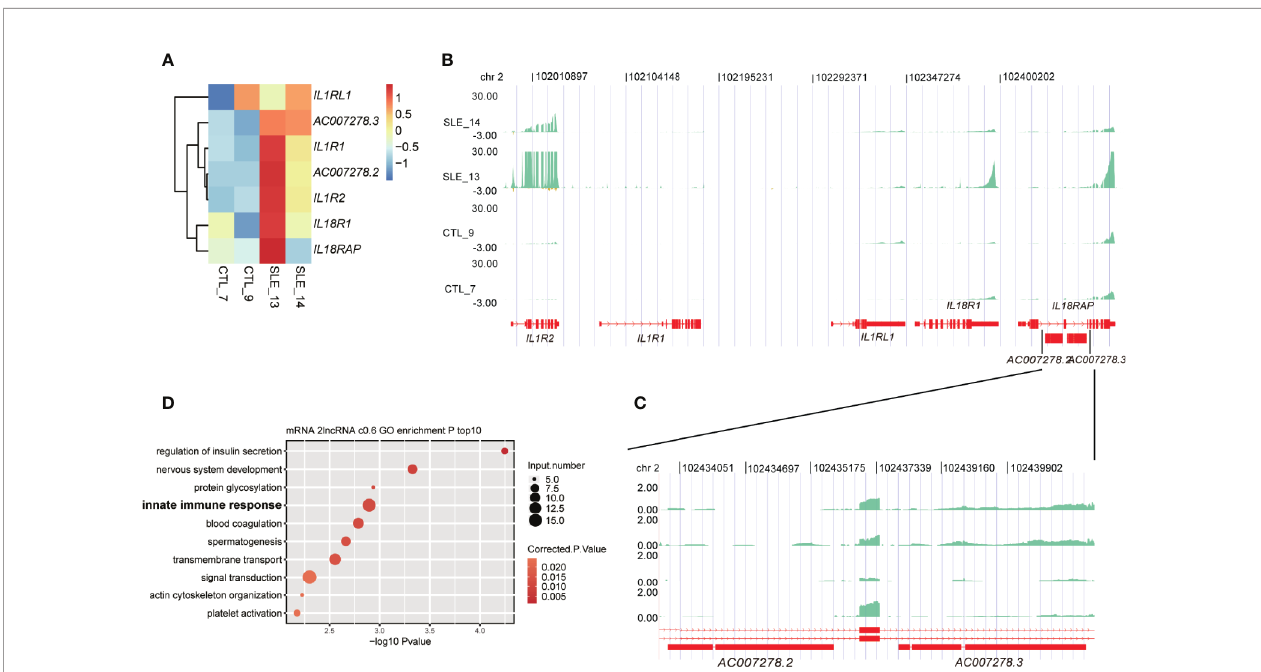
FIGURE 4 | One lncRNA cluster potentially regulated innate immune response-related gene expression. (A) Heat map shows the elevated expression levels of seven genes in the systemic lupus erythematosus samples in this study. (B) Read density plot shows the global locus distribution and expression levels of these seven genes from the cytokine cluster. The two lncRNAs are ampli fi ed for a detailed view. (C) The detailed read density distribution of the two target lncRNAs AC007278.2 / AC007278.3 is shown. (D) Bubble plot shows the top 10 enriched Gene Ontology biological process terms of genes that were co-expressed with AC007278.2 / AC007278.3